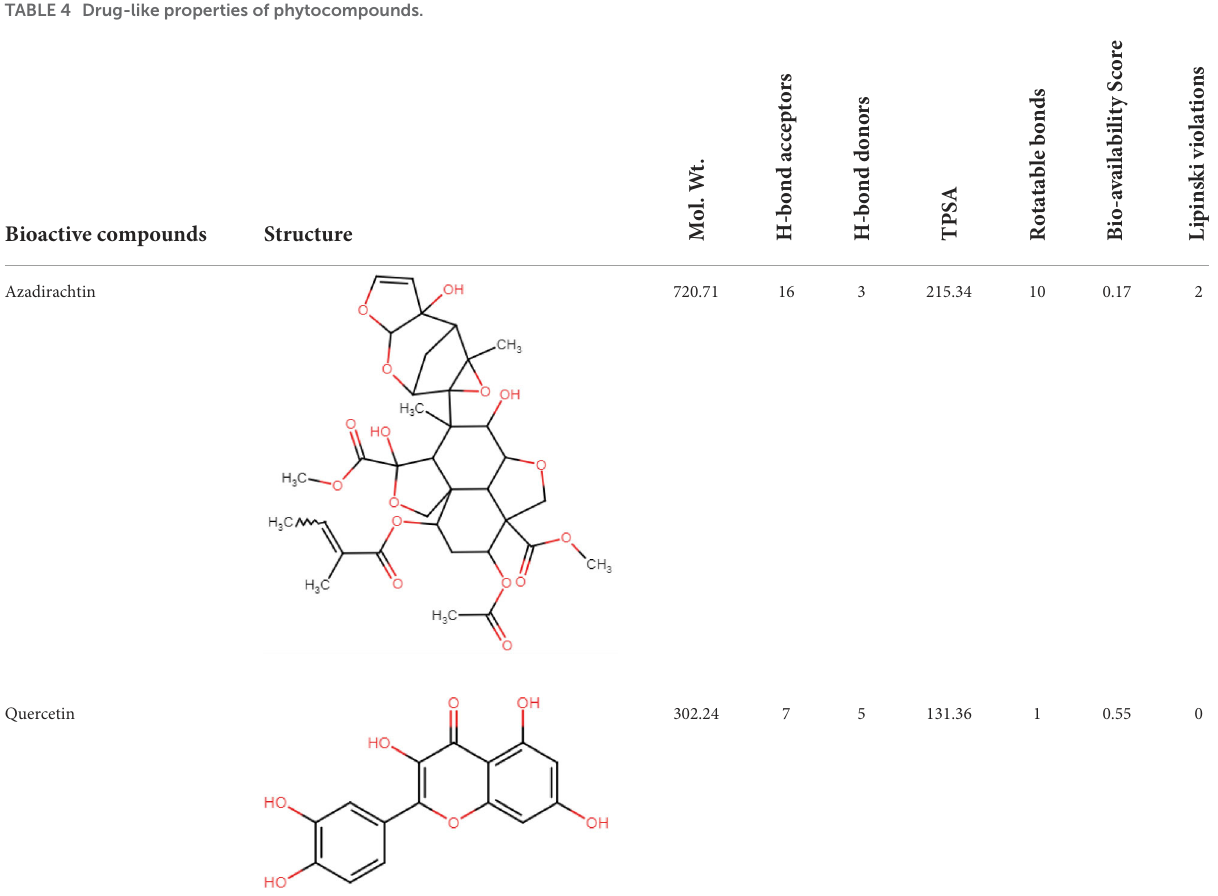
TABLE 4 Drug-like properties of